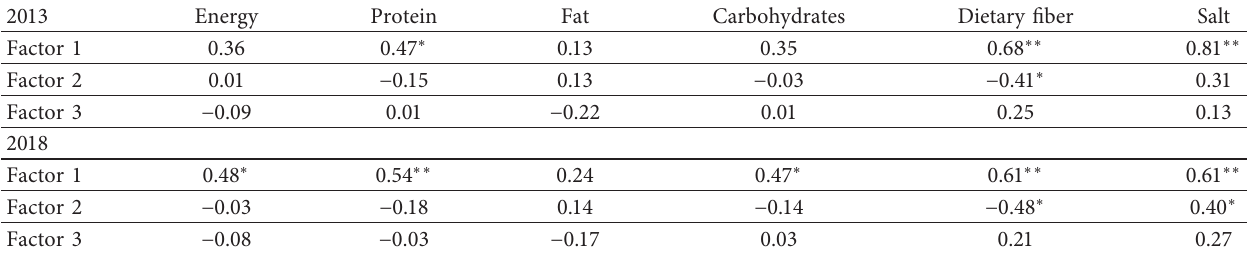
Figure 1: Distribution map of loading scores 1 to 3 in 2013 based on the Family Income and Expenditure Survey 2013. The values of 47 prefectural capitals of 52 cities are shown as different colors for each prefecture. See Table 5 and Supporting Figure S1. Table 6: Spearman’s correlation coefficient between the loading scores of 52 cities and nutrient consumption calculated from purchase